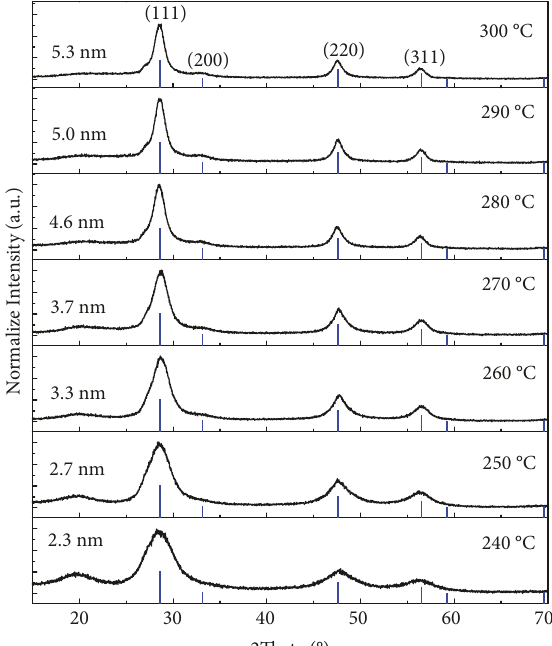
Figure 3: p-XRD patterns of ZnS nanoparticles obtained by decomposing ricinoleate carboxylate precursors in oleylamine: dodecanethiol (1:1) solvent mixtures at different temperatures for 1 hour. The blue lines are standard patterns for sphalerite ZnS (JCPDS 03-065-0309).